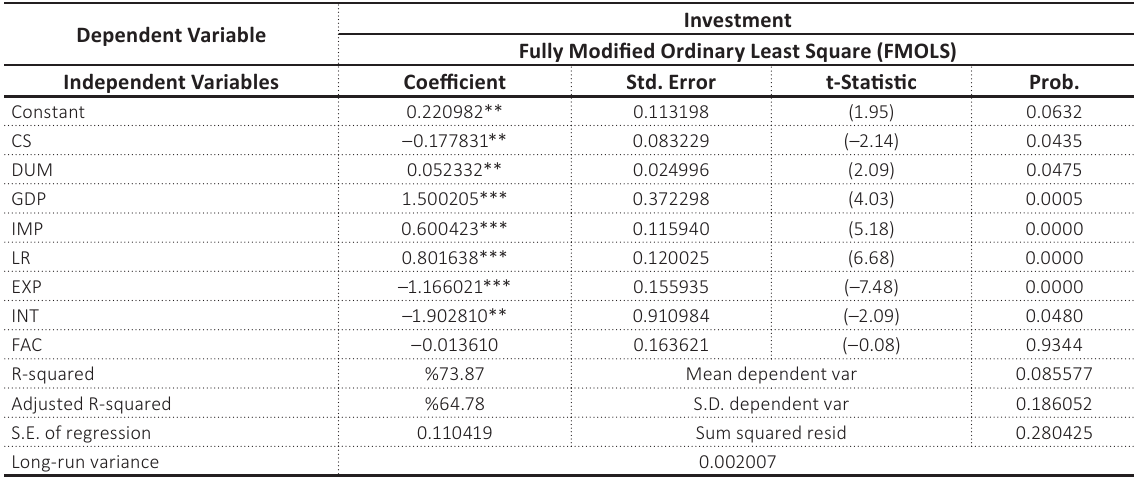
Table 4. The effect of various independent variables on Jordanian